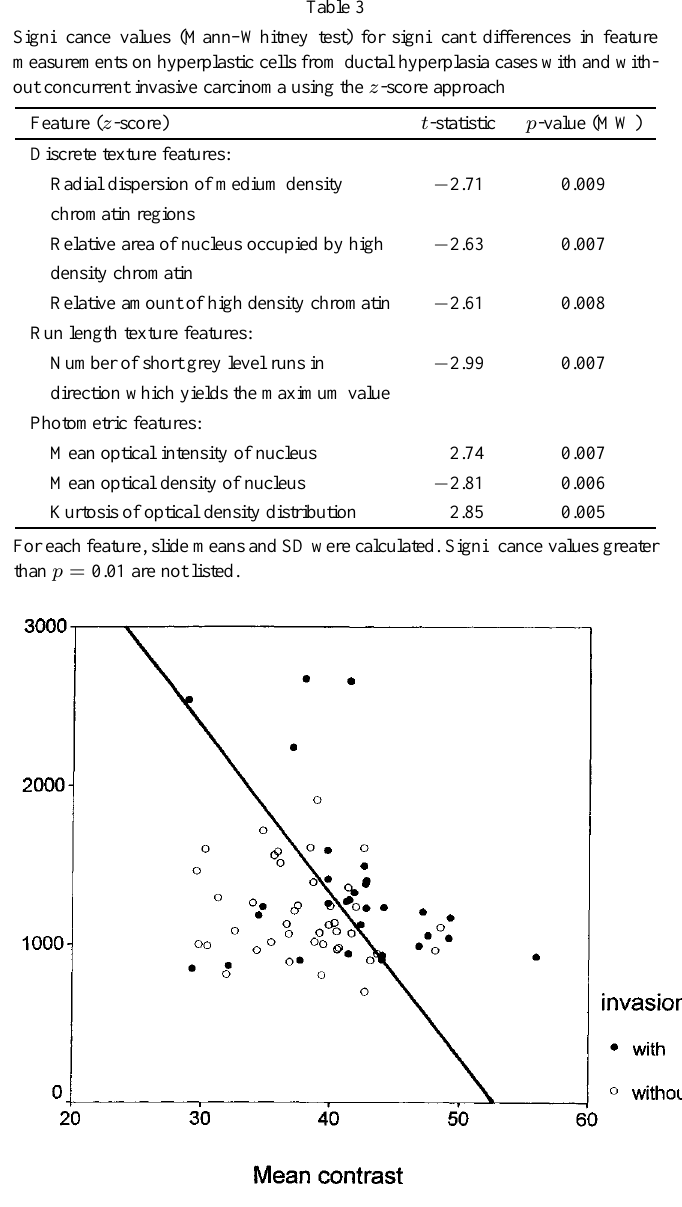
Fig. 2. Best separation of cases with ( (cid:15) ) or without ( (cid:14) ) invasive breast cancer, using image cytometry on ductal hyperplastic nuclei. Classification accuracy was 80% with discriminant function